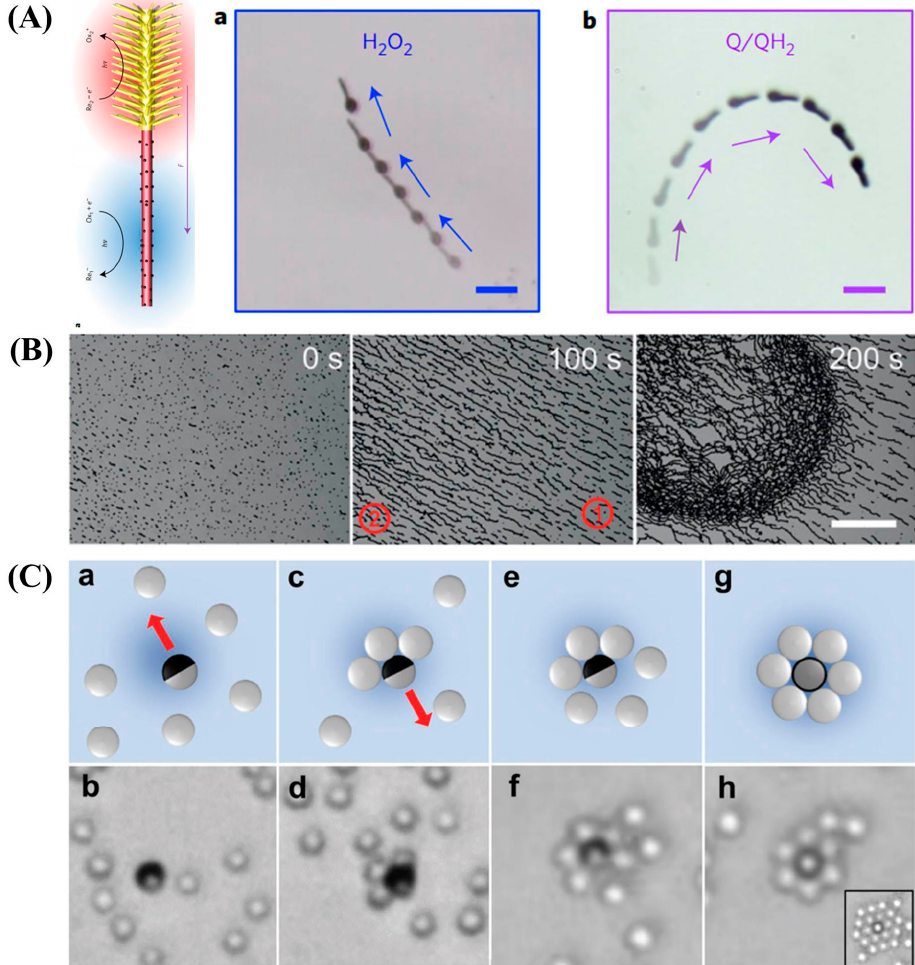
Figure 11. ( A ) Schematic of a Janus artificial microswimmer. Superimposed images of sequential frames show the migration of individual Janus nanotrees under global illumination in 0.1% H 2 O 2 (a)